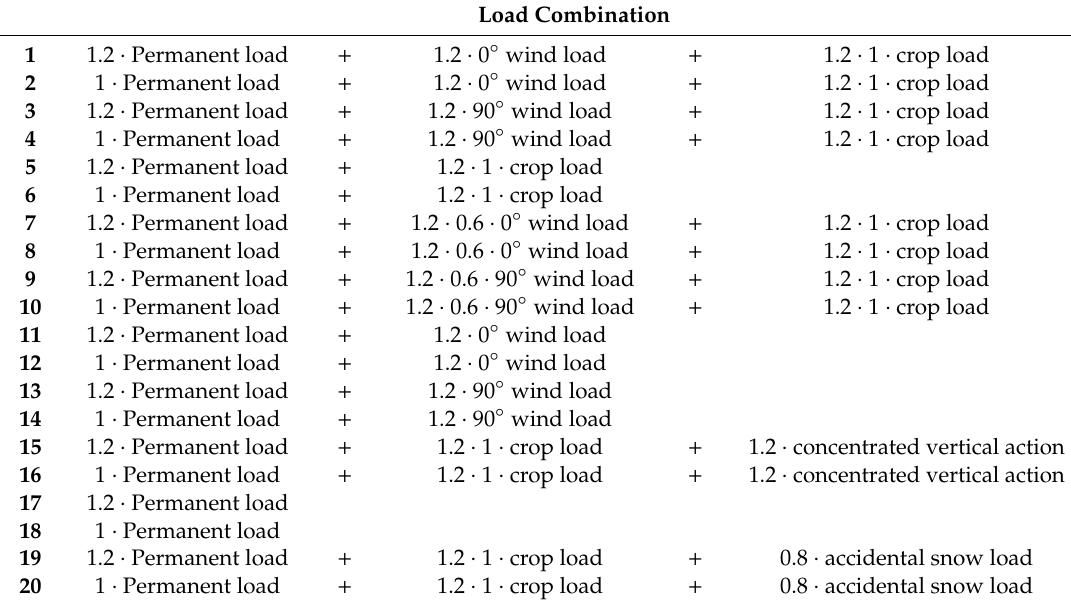
Table 2. External pressure coefficient and wind load values for 0° and 90° wind directions. Load Load Combination